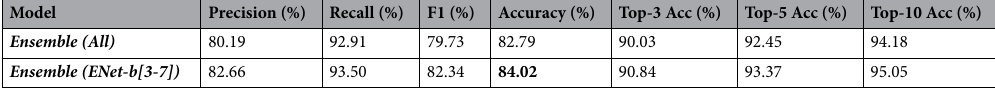
Table 3. Results for the Oriental Museum Dataset test split. ‘Ensemble’ refers to the score dervied using the average of class votes for all of the models. ‘Ensemble b[3-7]’ considers the strongest models only i.e. EfficientNet-b3,4,5,6,7. Significant values are in bold.